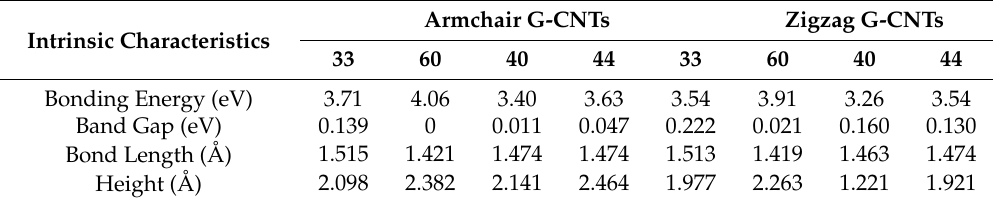
Table 1. The bonding energy, band gap, bond length, and height of armchair and zigzag G-CNTs.